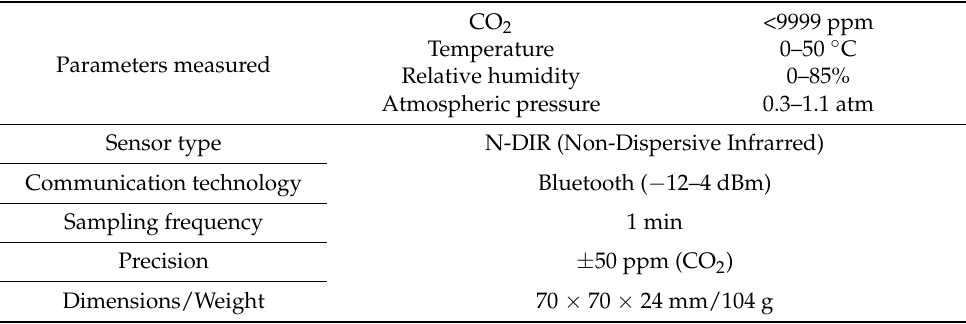
Table 1. Technical characteristics of the Aranet 4 Pro